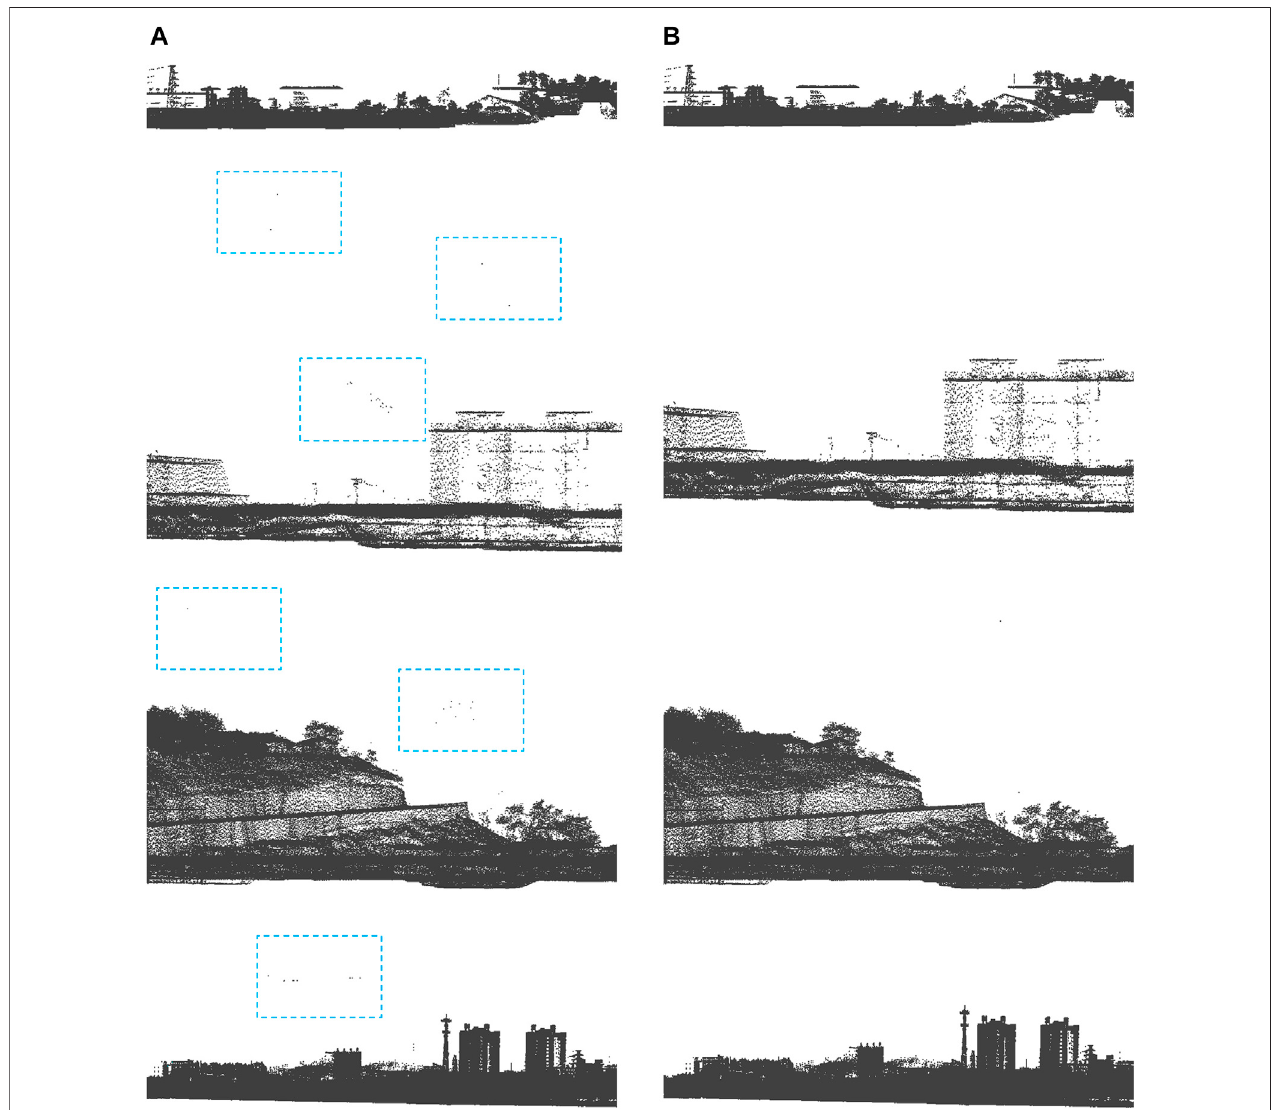
FIGURE 6 | Comparison before and after denoising. (A) Original point clouds with noise points; (B) Point clouds after denoising.